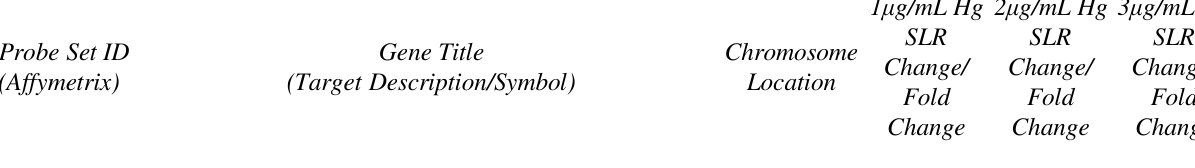
Table 1 contd.: Sample genes affected by mercury.